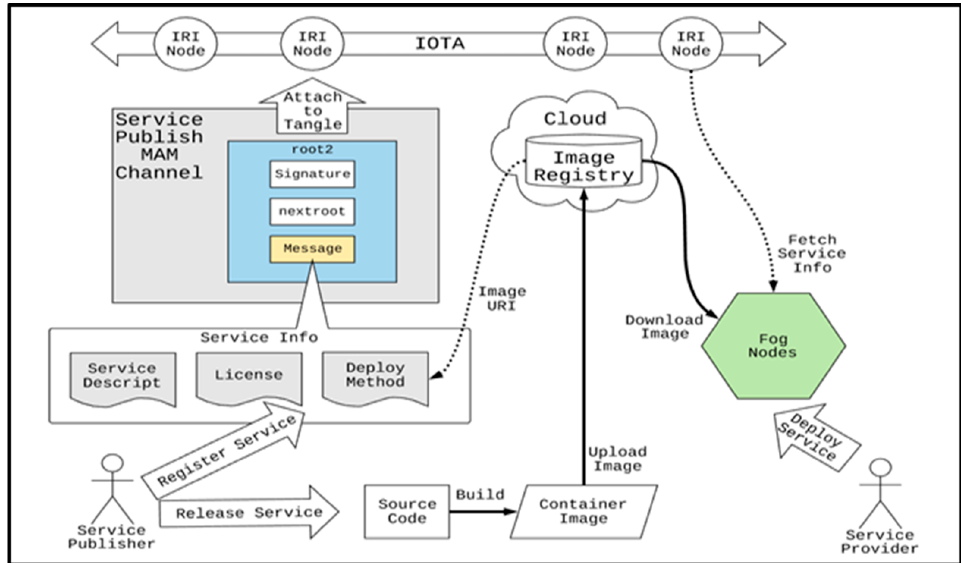
Figure 4. Service release and deployment in IBSD .